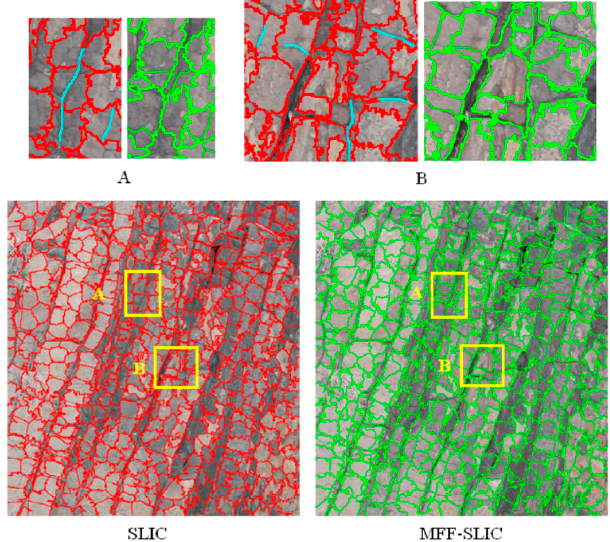
Figure 17. The comparison of segmentation results with 500 superpixels.